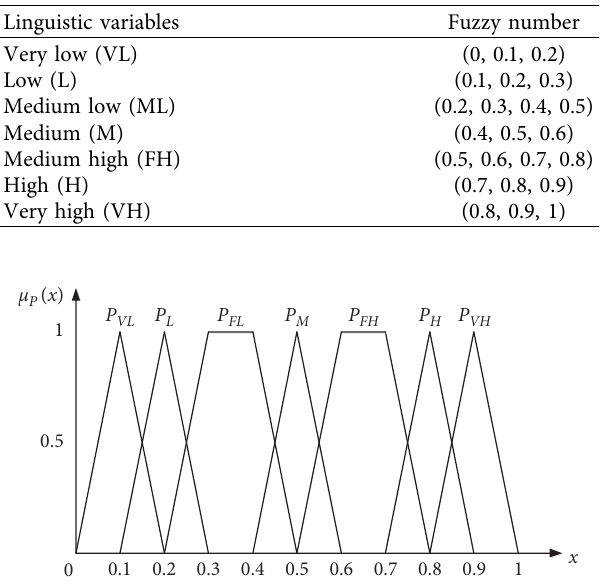
Figure 3: Membership function of fuzzy linguistic variables.